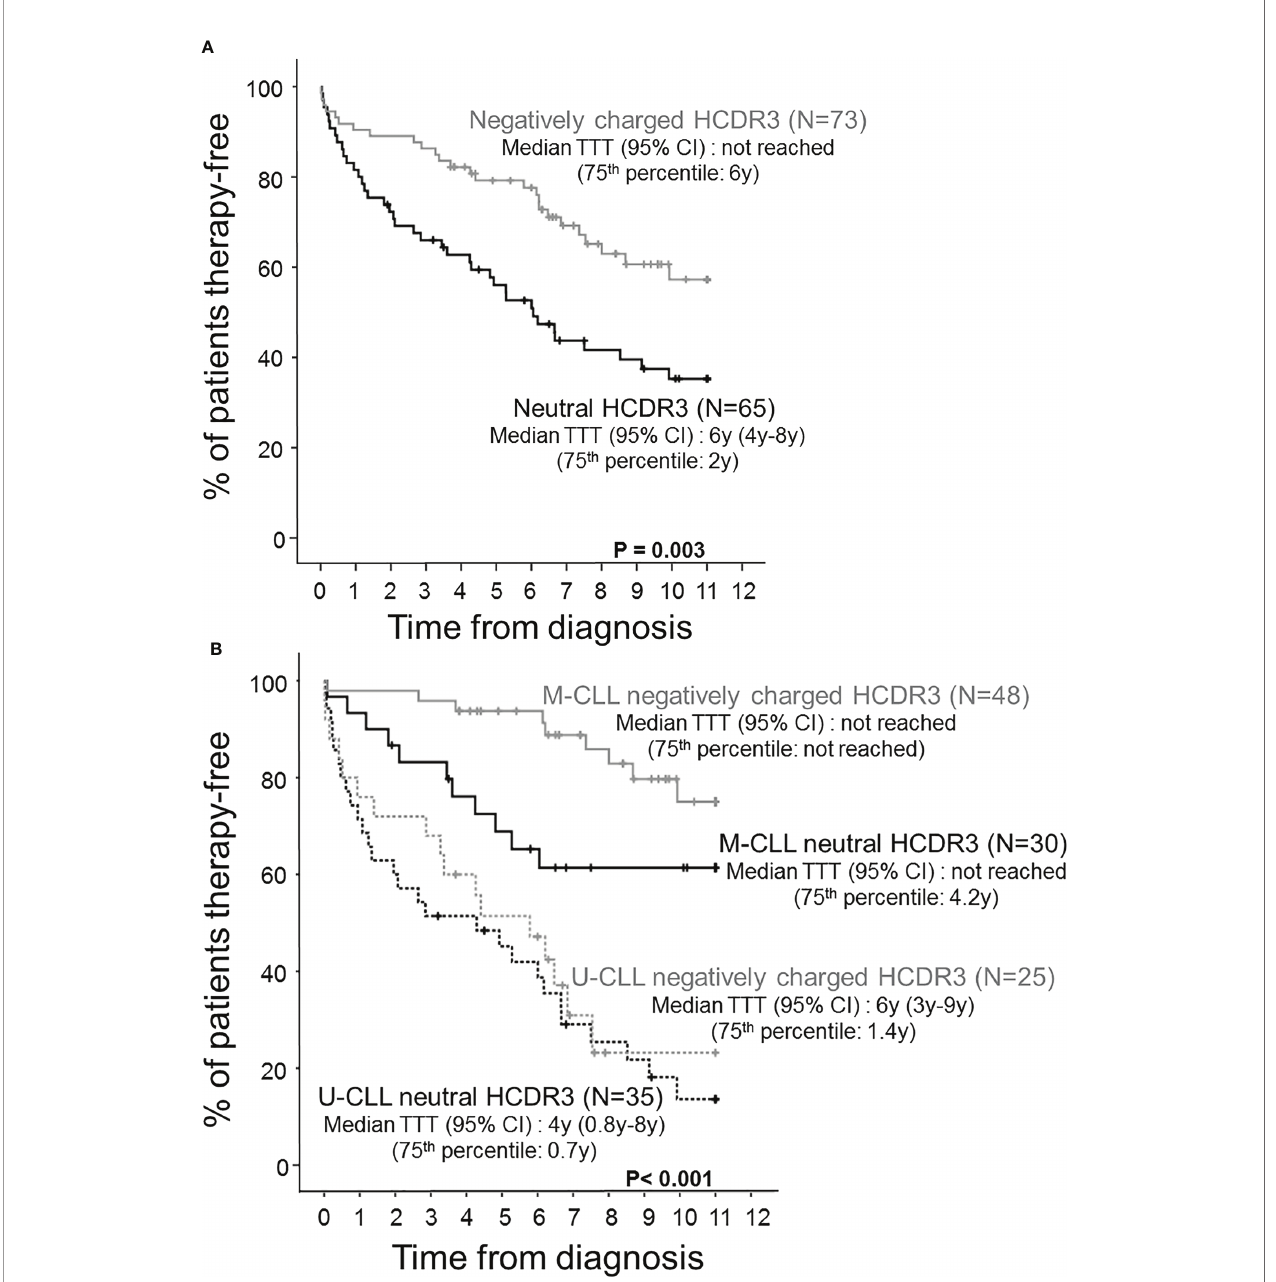
FIGURE 2 | Time to therapy (TTT) survival curves of CLL patients distributed according to the hydropathy index of the HCDR3 aa sequence and the mutational status of their tumor cell BCR. Prognostic impact of the HCDR3 hydropathy index (A) and both the HCDR3 hydropathy index and the IGHV mutational status (B) on the outcome of CLL patients assessed by their survival from diagnosis to fi rst therapy